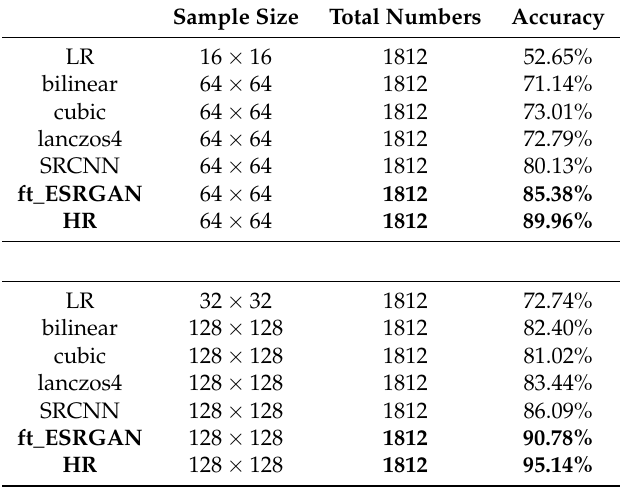
Table 4. Comparison of classification results for LR and SR images based on 10